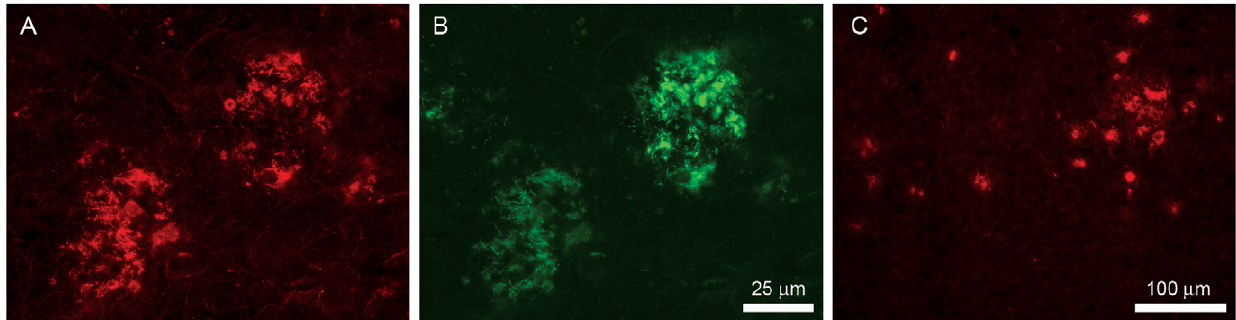
Figure 3. Immunohistochemical staining of brain tissue. A , a brain section (hippocampus) of an 85-year-old female AD patient (NBB 1999-030) was stained with mouse anti-cyclo[A b (22–28)-YNGK 9 ] serum and ( B ) co-stained with an antibody against APP (6E10). The neuropathological diagnosis of the is patient is Braak stage for neurofibrillary tangles 6 and for amyloid B [43]. C , immunostaining of a plaque-loaded cortex of a 9 month old APPswe/PS1dE9 transgenic mouse.